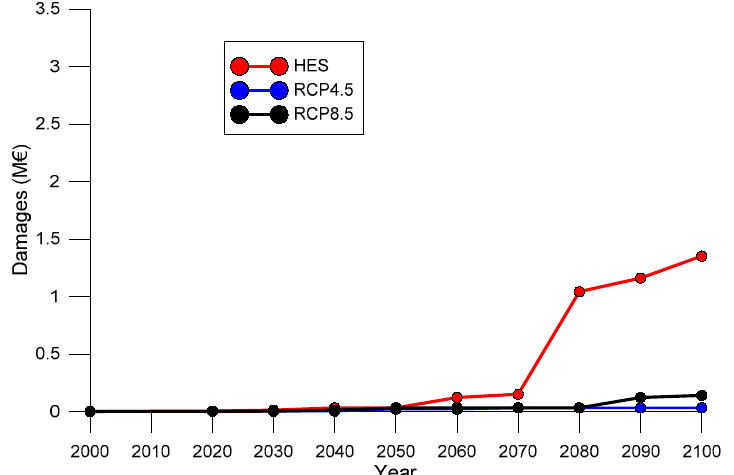
Figure 5. Estimation of damages (in millions of euros) in Catalan ports due to overtopping for the three SLR scenarios and for a return period of 5 years.